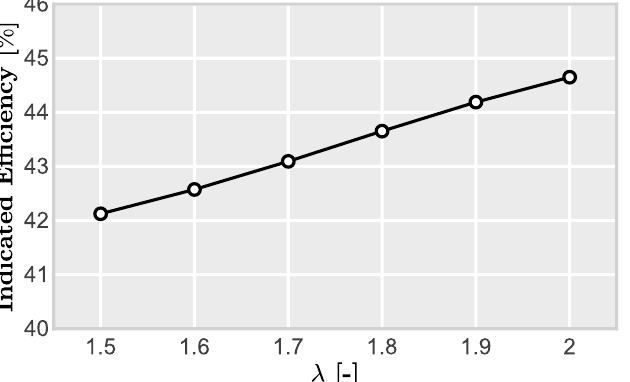
Figure 17. Indicated efficiency trends when the air dilution rate is increased from λ = 1.5 to λ = 2.0 using hydrogen as